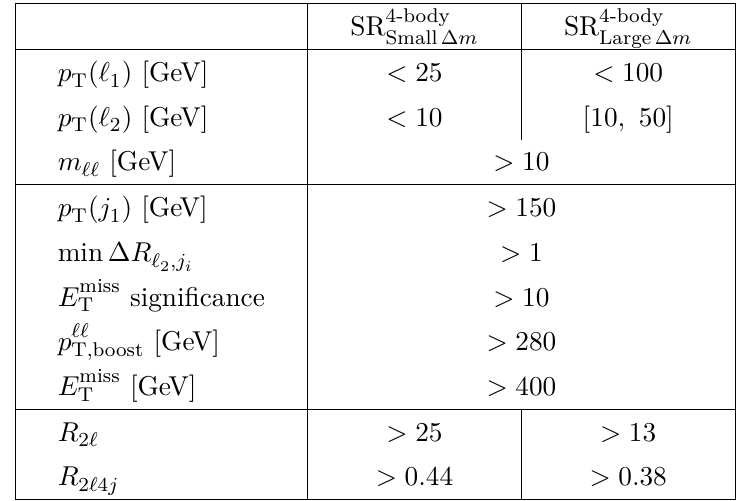
Table 4 . Four-body selection. Signal regions